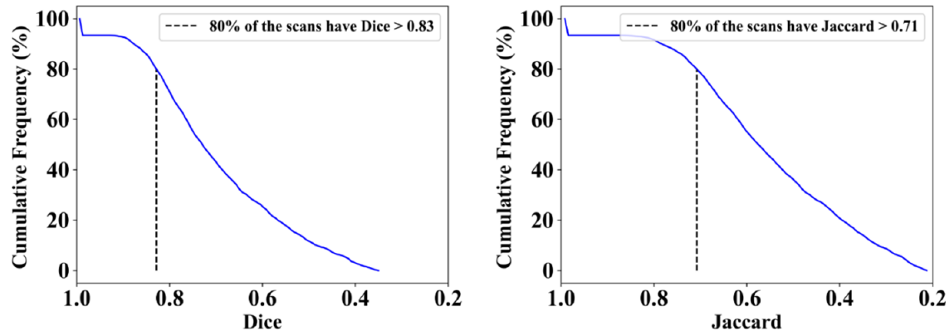
Figure 16. Cumulative frequency plot for Dice ( left ) and Jaccard ( right ) for ResNet-UNet when computed against MD 1.